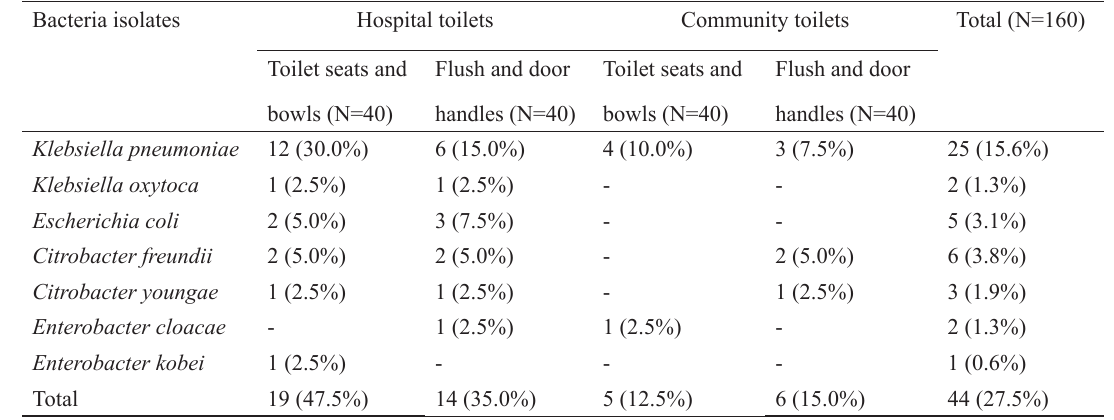
Table 2: Distribution pattern of ESBL-producing Enterobacteriaceae in public toilets in Abeokuta, Nigeria. Bacteria